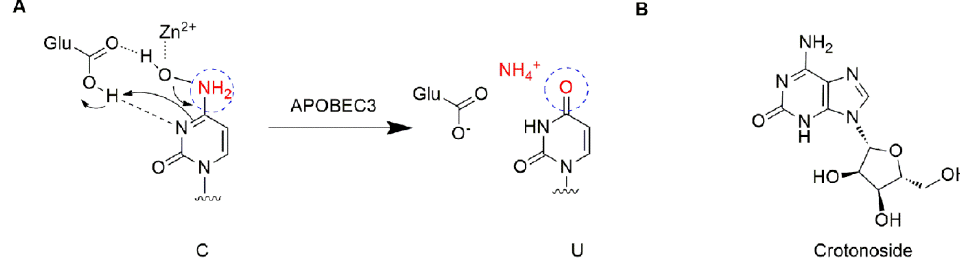
Figure 1. Structure description: ( A ) The proposed mechanism of ssDNA C-to-U deamination medi- ated by APOBEC3. ( B ) The structure of crotonoside.